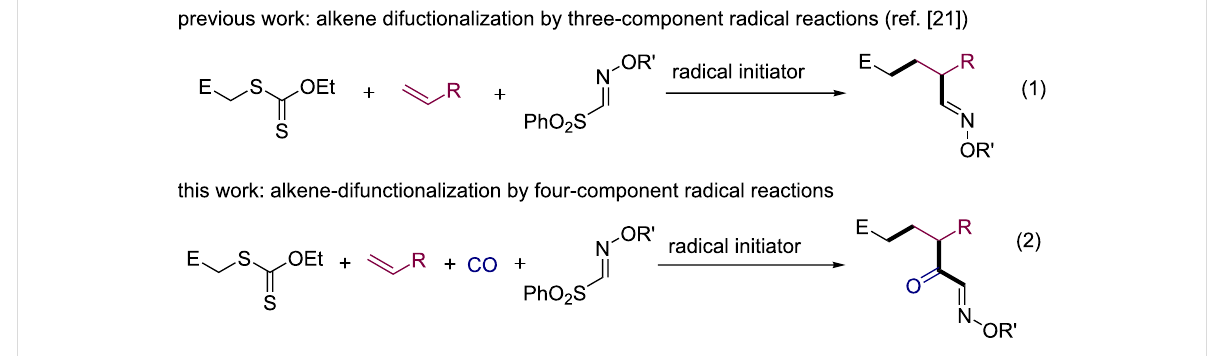
Table 1: Four-component coupling reaction of ethyl 2-((ethoxycarbonothioyl)thio)acetate ( 1a ), 1-octene ( 2a ), CO, and sulfonyl oxime ether 3a under radical conditions a .